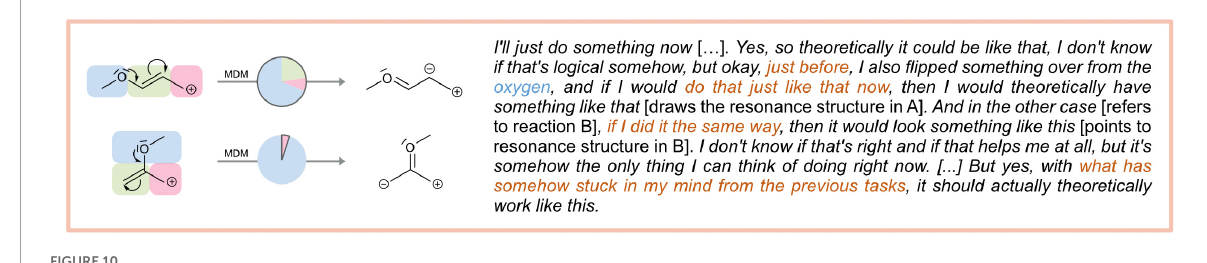
FIGURE10 Nina’s drawing moves, fixation duration rates on the structural features and drawing description for her drawings in reaction A and B. The orange frame indicates the unproductivity of the resulting drawings.